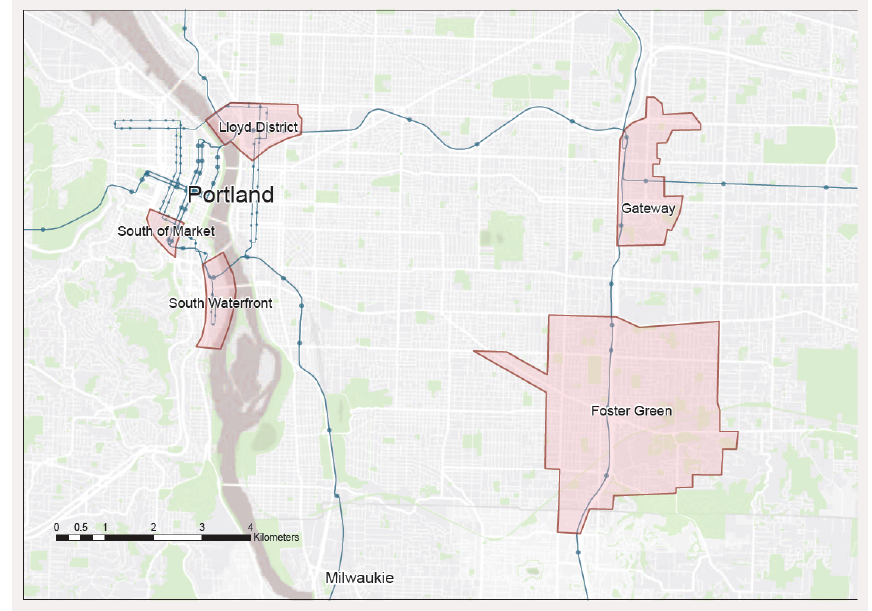
Figure 6: Portland’s five